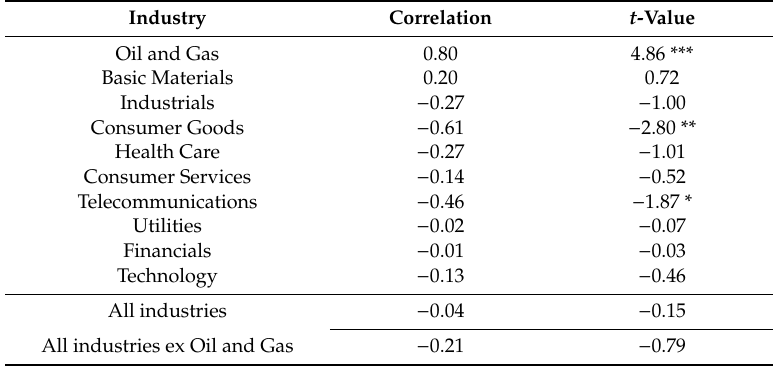
Table A3. Correlations between the government’s petroleum cash flow and the unweighted operating cash flows of each ICB